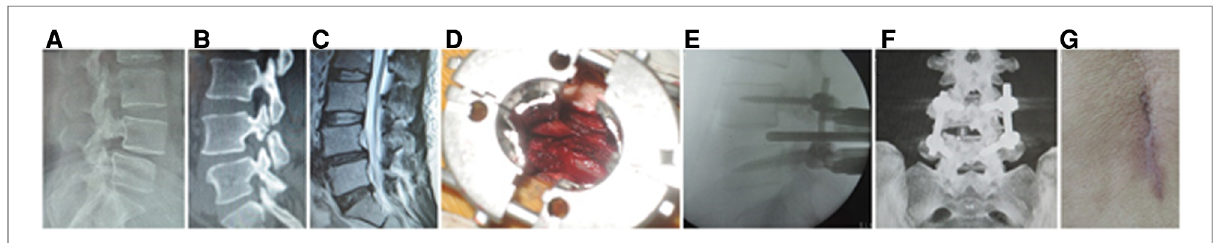
FIGURE 2 ( A ) X-ray, ( B ) CT, and ( C ) MRI showed L4 spondylolisthesis (I°) caused by spondylolysis in a 44-year-old female patient. ( D ) An expandable tubular retractor was placed to undertake unilateral complete facetectomy and hemilaminectomy and expose dural sac nerve root. The cage was inserted into L4/5 intervertebral space on ( E ) lateral C-arm view and ( F ) 3D CT reconstruction showed the screws, cage, and neurologic decompression in MIS-TLIF. ( G ) The incision of MIS-TLIF was closed. MIS-TLIF, minimally invasive surgery-transforaminal lumbar interbody